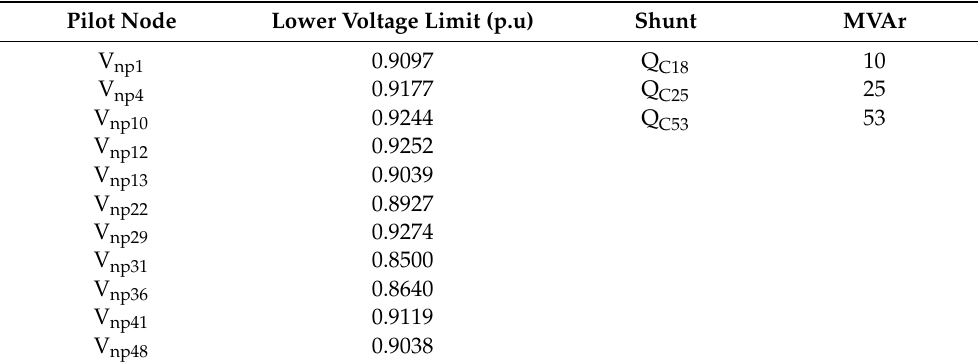
Table 1. Lower voltage limits of pilot nodes and MVAr parameters of shunt elements (IEEE 57-bus test system).